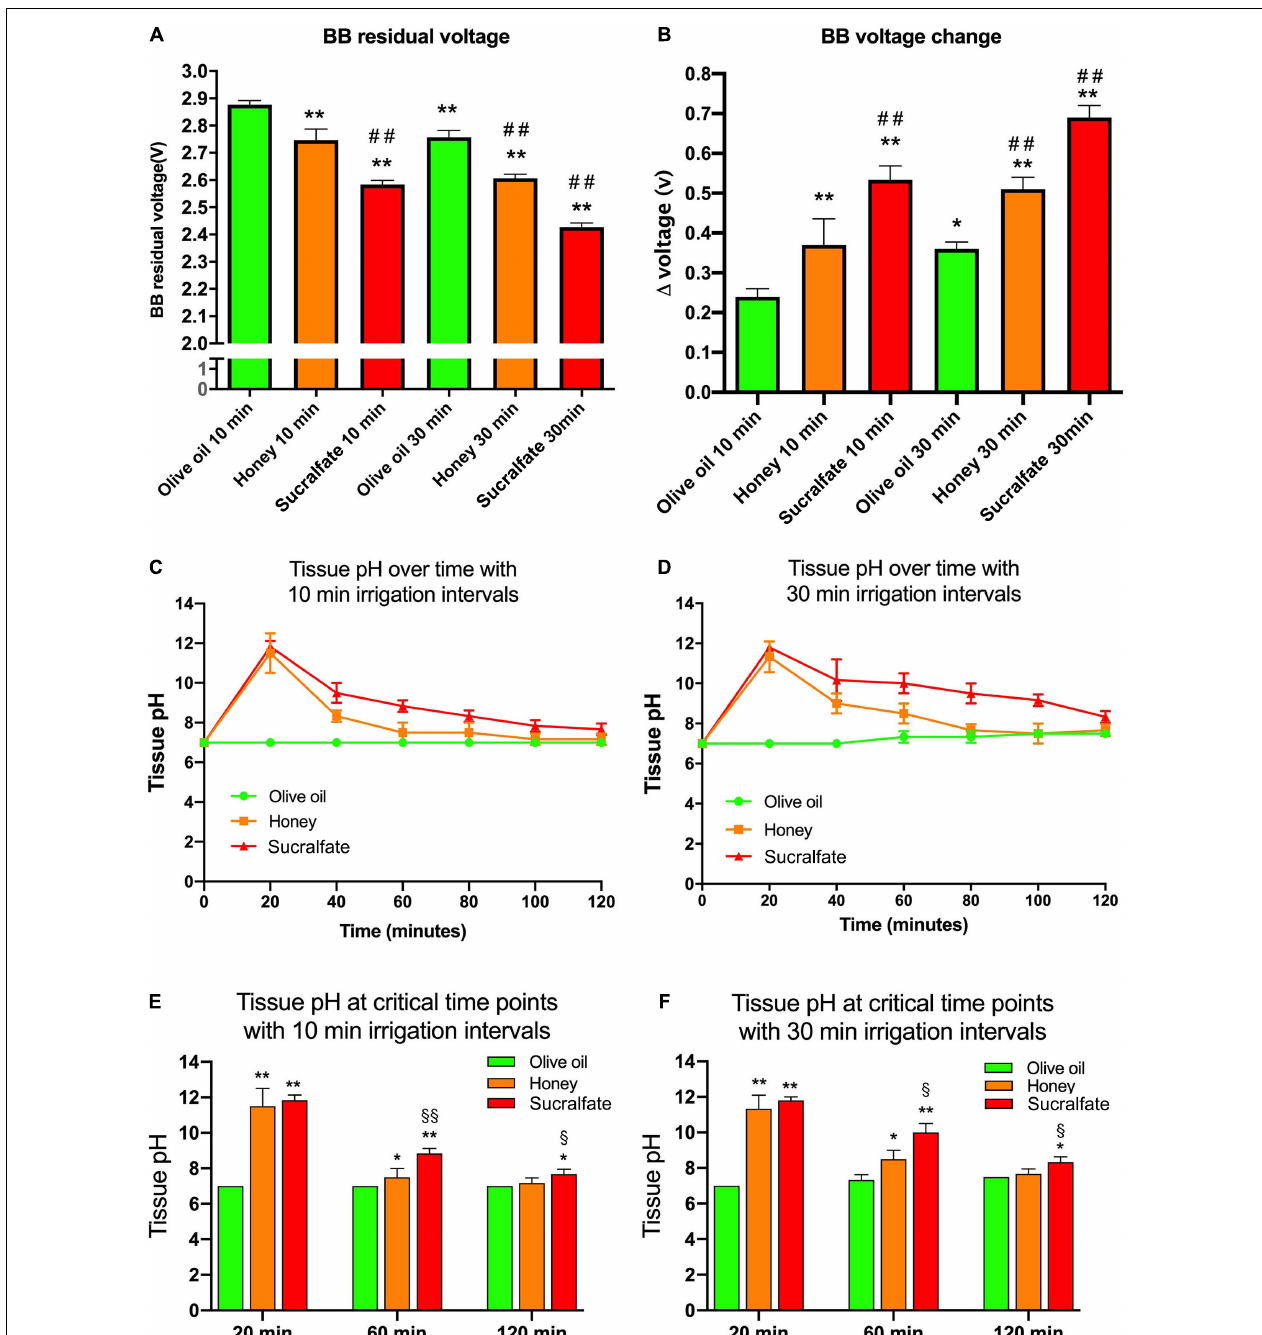
FIGURE 2 | The button battery discharge and esophageal tissue alkalization after different treatments in vitro ( n = 6). (A) The residual voltage of button batteries after esophageal injury. (B) The discharged voltage of button batteries after esophageal injury. (C) The change of the tissue pH value of esophagi treated with 10 min time interval irrigations. (D) The change of the tissue pH value of esophagi treated with 30 min time interval irrigations. (E) The tissue pH value at critical time points of esophagi treated with 10 min time interval irrigations. (F) The tissue pH value at critical time points of esophagi treated with 30 min time interval irrigations. * P < 0.05 vs. Olive oil 10 min group; ** P < 0.01 vs. Olive oil 10 min; ## P < 0.01 vs. Honey 10 min; § P < 0.05 vs. Honey 30 min; §§ P < 0.01 vs. Honey 30